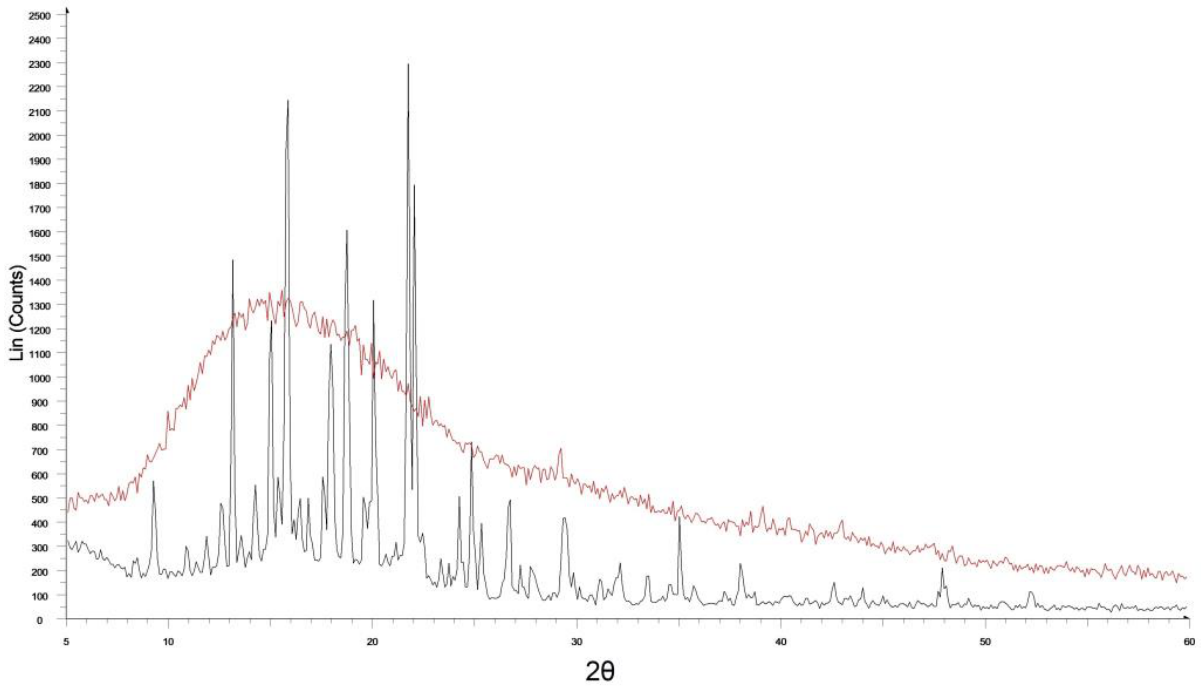
Figure 3. X-ray diffraction patterns of pure CYT (black) and Film B (red) reported as a representative example for all the prepared film.